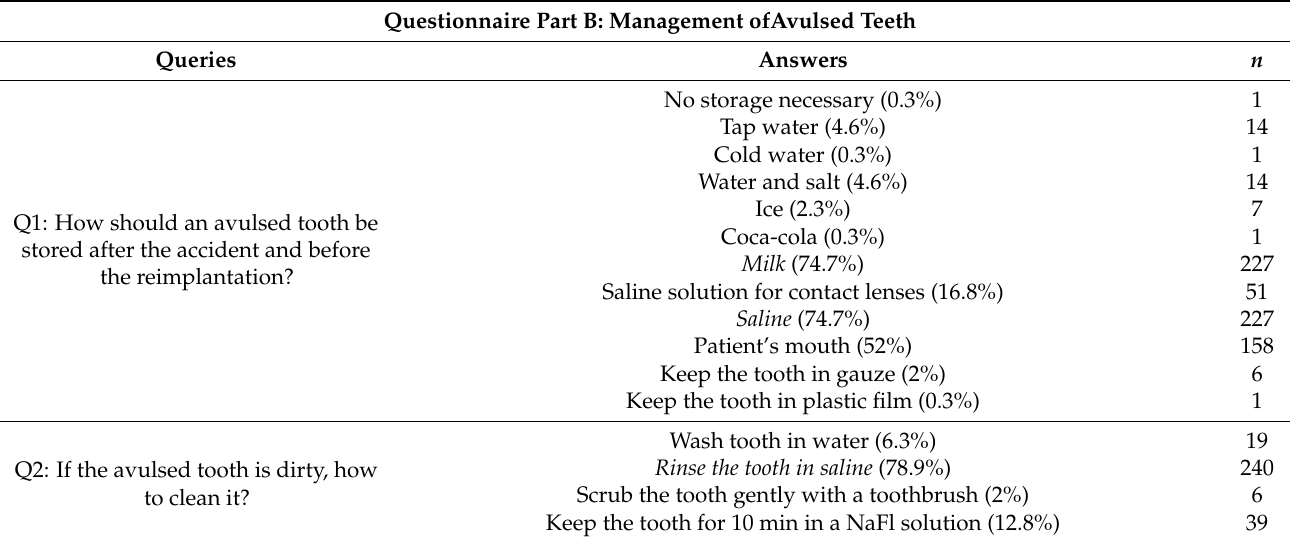
Table 2. The answers given by the respondents. The correct answers are marked in italics. Questionnaire Part B: Management ofAvulsed